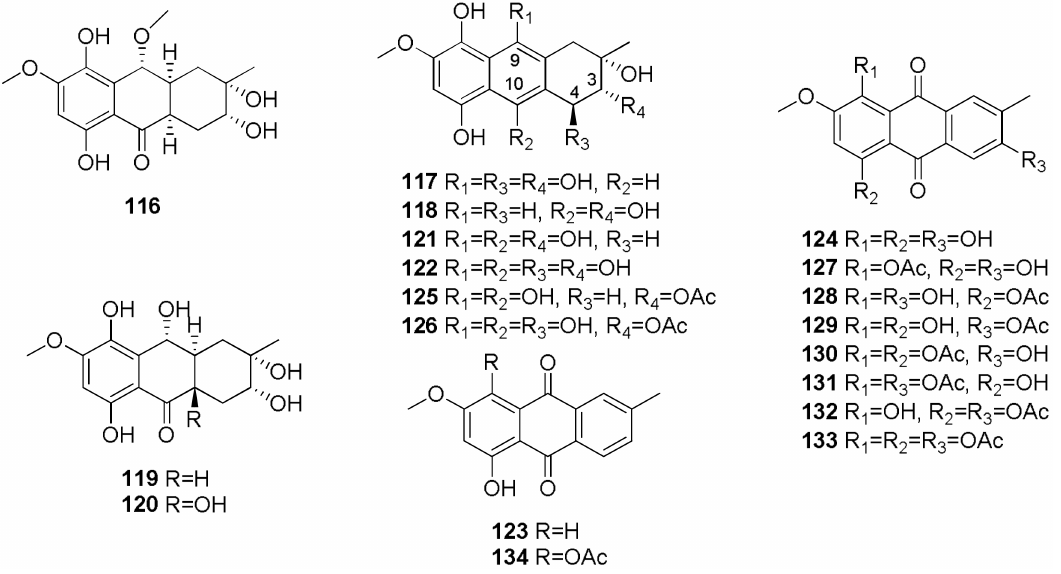
Figure 9. The structures of 4a- epi -9 α -methoxydihydrodeoxybostrycin ( 116 ), 10-deoxybostrycin ( 117 ), nigrosporin B ( 118 ), 9 α -hydroxydihydrodesoxybostrycin ( 119 ), 9 α -hydroxyhalorosellinia A ( 120 ), 4-deoxybostrycin ( 121 ), bostrycin ( 122 ), austrocortirubin ( 123 ), 3,5,8-trihydroxy-7-methoxy- 2-methylanthracene-9,10-dione ( 124 ), 3-acetoxy-4-deoxybostrycin ( 125 ), 3-acetoxybostrycin ( 126 ), 8-acetoxy-3,5-dihydroxy-7-methoxy-2-methylanthracene-9,10-dione ( 127 ), 5-acetoxy-3,8-dihydroxy-7- methoxy-2-methylanthracene-9,10-dione ( 128 ), 3-acetoxy-5,8-dihydroxy-7-methoxy-2-methylanthracene- 9,10-dione ( 129 ), 5,8-diacetoxy-3-hydroxy-7-methoxy-2-methylanthracene-9,10-dione ( 130 ), 3,8- diacetoxy-5-hydroxy-7-methoxy-2-methylanthracene-9,10-dione ( 131 ), 3,5-diacetoxy- 8-hydroxy-7- methoxy-2-methylanthracene-9,10-dione ( 132 ), 3,5,8-triacetoxy-7-methoxy-2-methylanthracene-9,10- dione ( 133 ), and 8-acetoxyaustrocortirubin ( 134